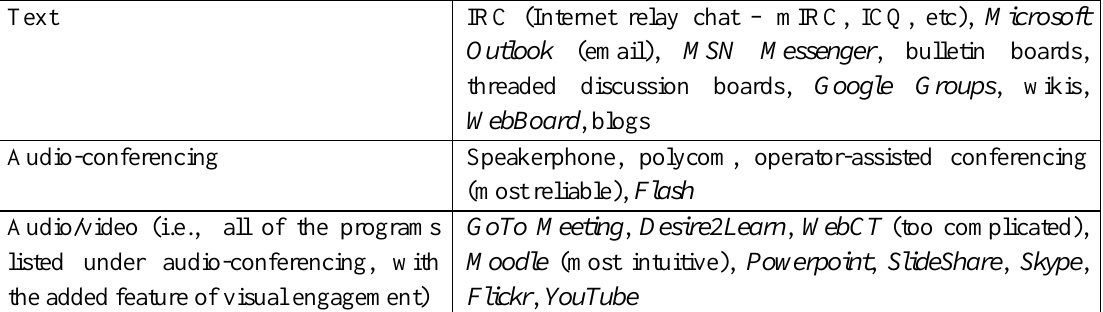
Table 2 The Author’s Journey with Different DE Tools and Technologies